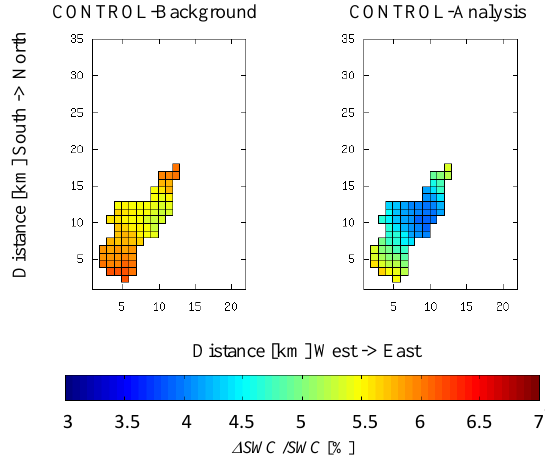
Fig. 15. The difference in soil-water content (SWC) of each grid cell relative to the CONTROL SWC of each grid cell for the ini- tial time t =0 (5 May 1997) for the background and analysis. The analysis was obtained assimilating streamflow from the CONTROL model simulation from the Große Enz outlet, Kleine Enz outlet and Eyach outlet with a 0.5 hourly